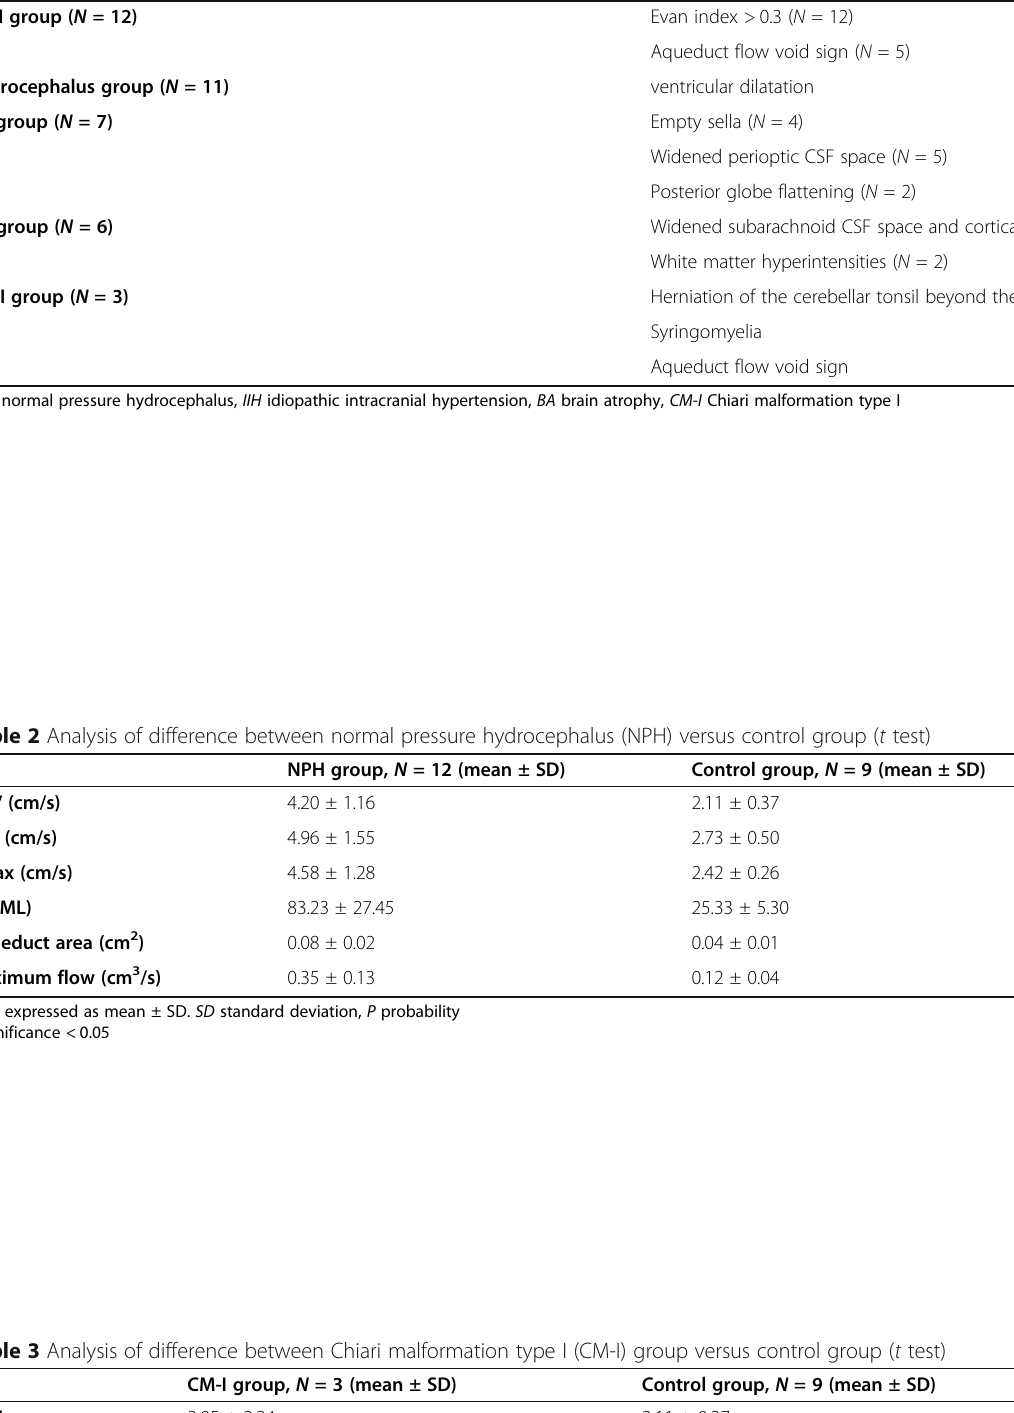
Table 1 Conventional MRI findings in each group Group